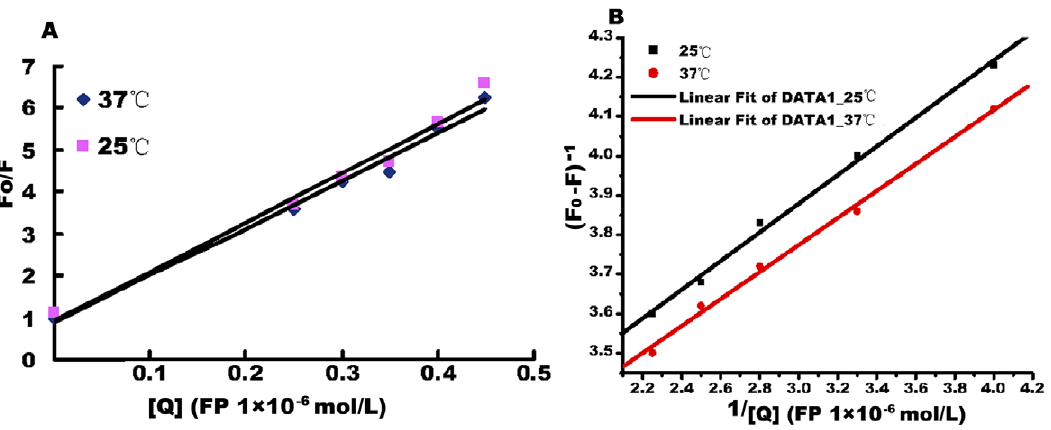
Figure 9. Calculation of binding constants. A) Stern-Volmer plots of FP and CaM-Ca 2 + -PDE system at different temperature (25 u C and 37 u C). B) Line weaver-Burk plots of FP versus CaM-Ca 2 + -PDE at 25 u C and 37 u C; k 25 u C =6.24 6 10 4 M 2 1 and k 37 u C =4.8 6 10 4 M 2 1 , K represents binding